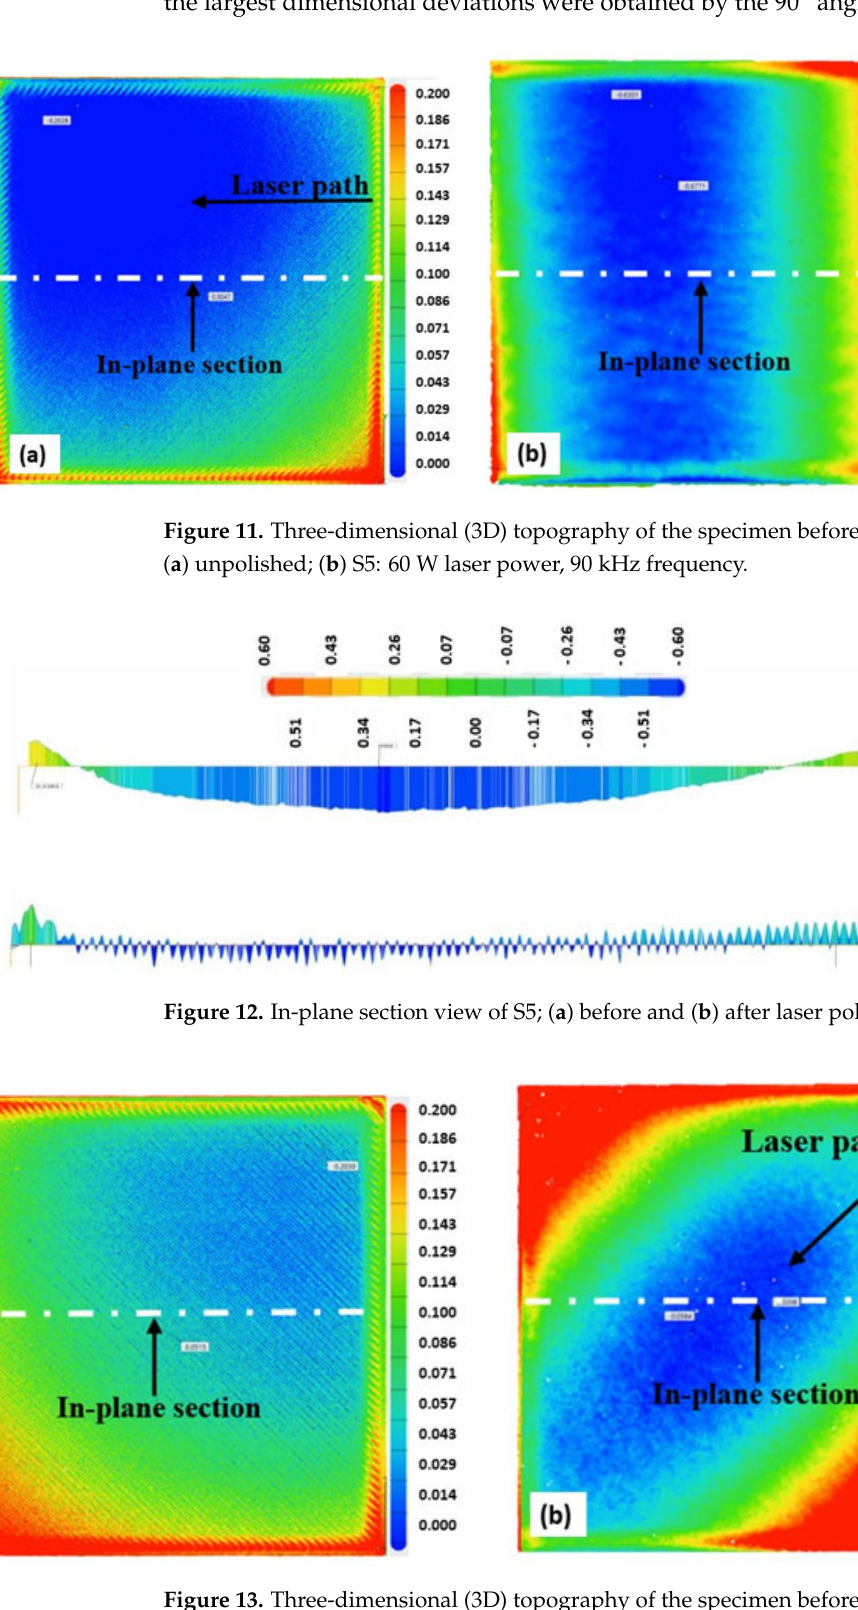
Figure 14. In ‐ plane section view of S3; ( a ) before and ( b ) after laser polishing.